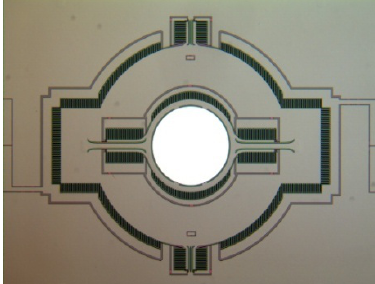
Figure 15. Biaxial gimbal mounted MEMS scanning mirror for Lissajous laser